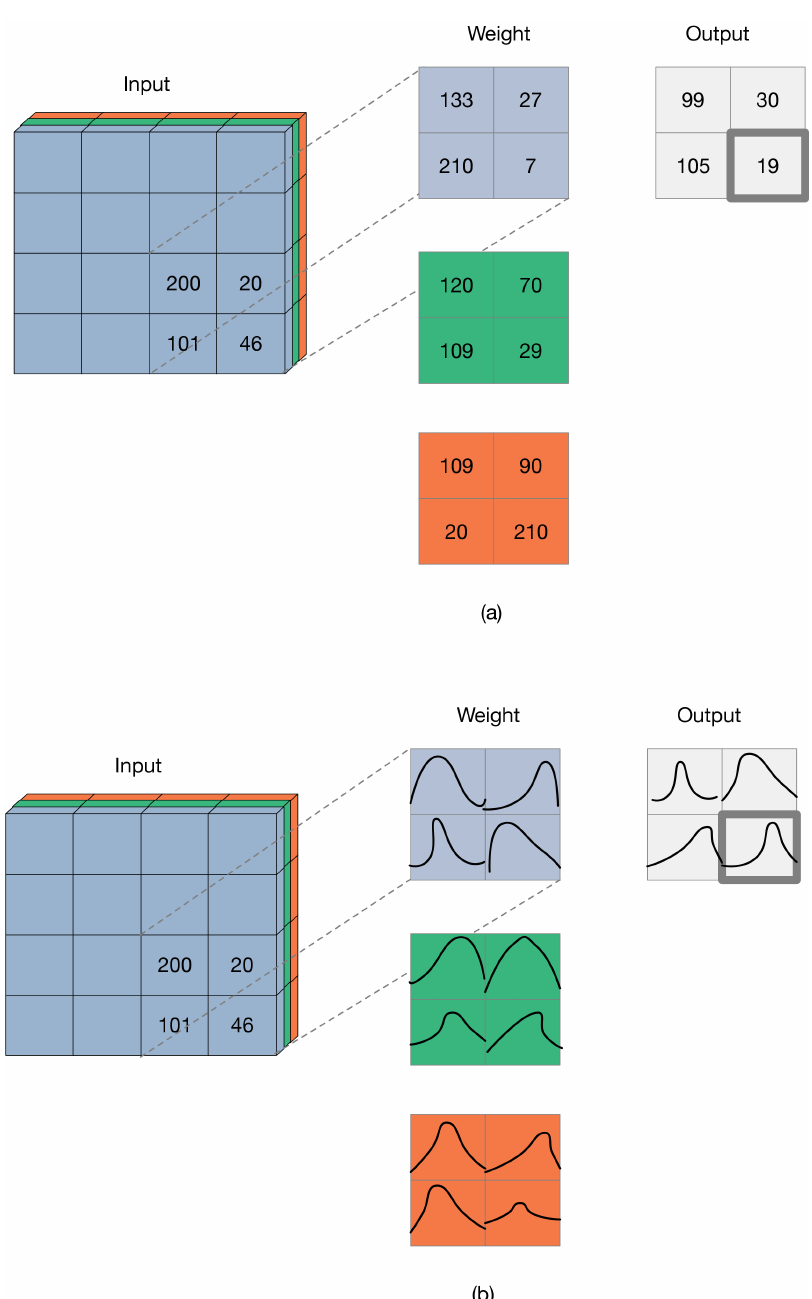
Figure 6. The differences between the Bayesian deep network and non-Bayesian deep network are ( a ) the weight optimization process for the non-Bayesian deep network, where the weight is a certain value, and ( b ) the weight optimization process for the Bayesian deep network, where the weight’s distribution is